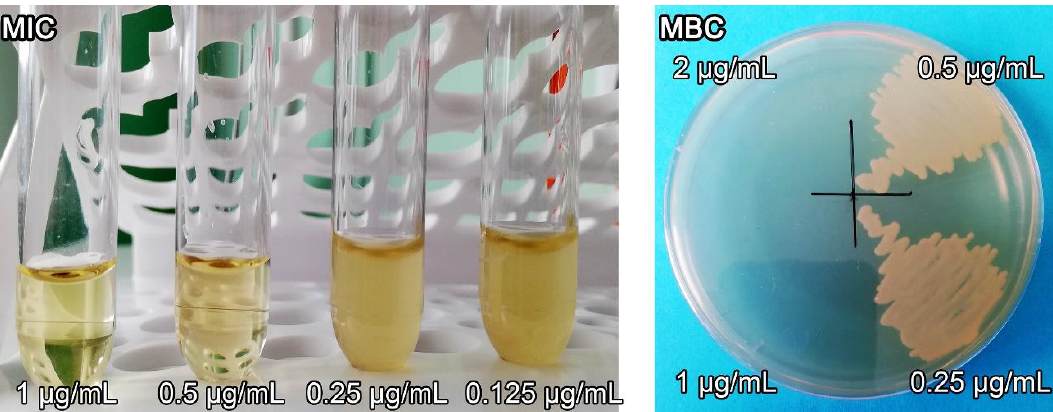
Figure 10. Minimum inhibitory and minimum bactericidal concentrations of AgNPs nanocomposite for Escherichia coli. for Escherichia coli